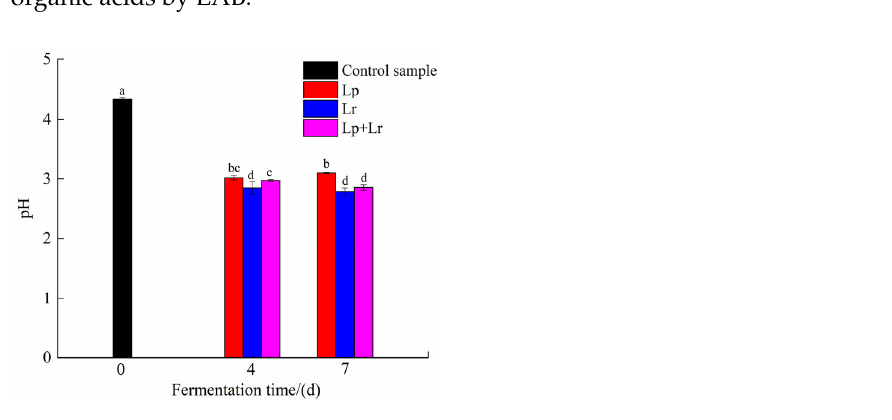
Figure 1. The value of pH in edible grass during fermentation. Different superscript letters in the columns indicate significant difference ( p < 0.05). Abbreviations: Lp, Lactobacillus plantarum ; Lr, Lactobacillus rhamnosus ; Lp + Lr, mixture of Lactobacillus plantarum and Lactobacillus rhamnosus .